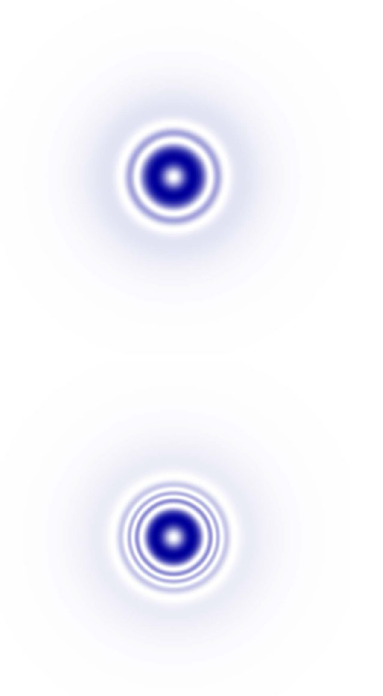
Fig. 6 The energy density in Eq. (48) in the plane for α = 3 and n = 1 (top) and 2 (bottom). The intensity of the blue color increases with the increasing of the energy densities